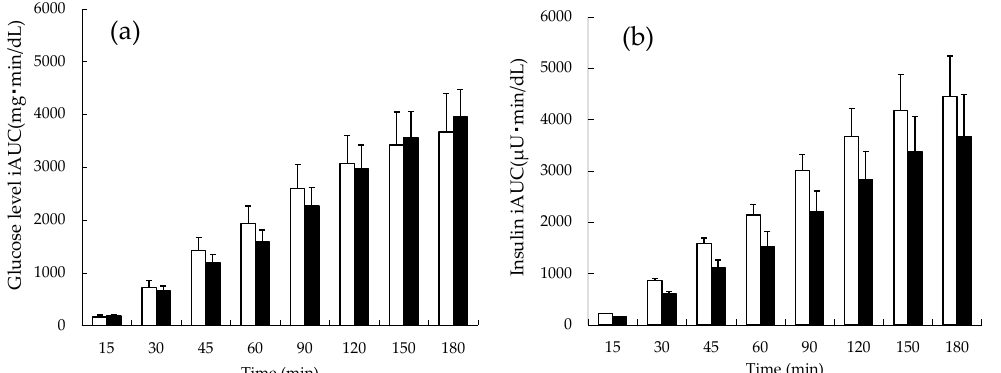
Figure 2. Cumulative incremental area under the curve (iAUC) of blood glucose and insulin in healthy normal subjects. ( a ) Blood glucose. ( b ) I nsulin. □: rice -first group, ■: apple-first group ( n = 10). No significant difference was noted between the rice-first and apple-first groups.